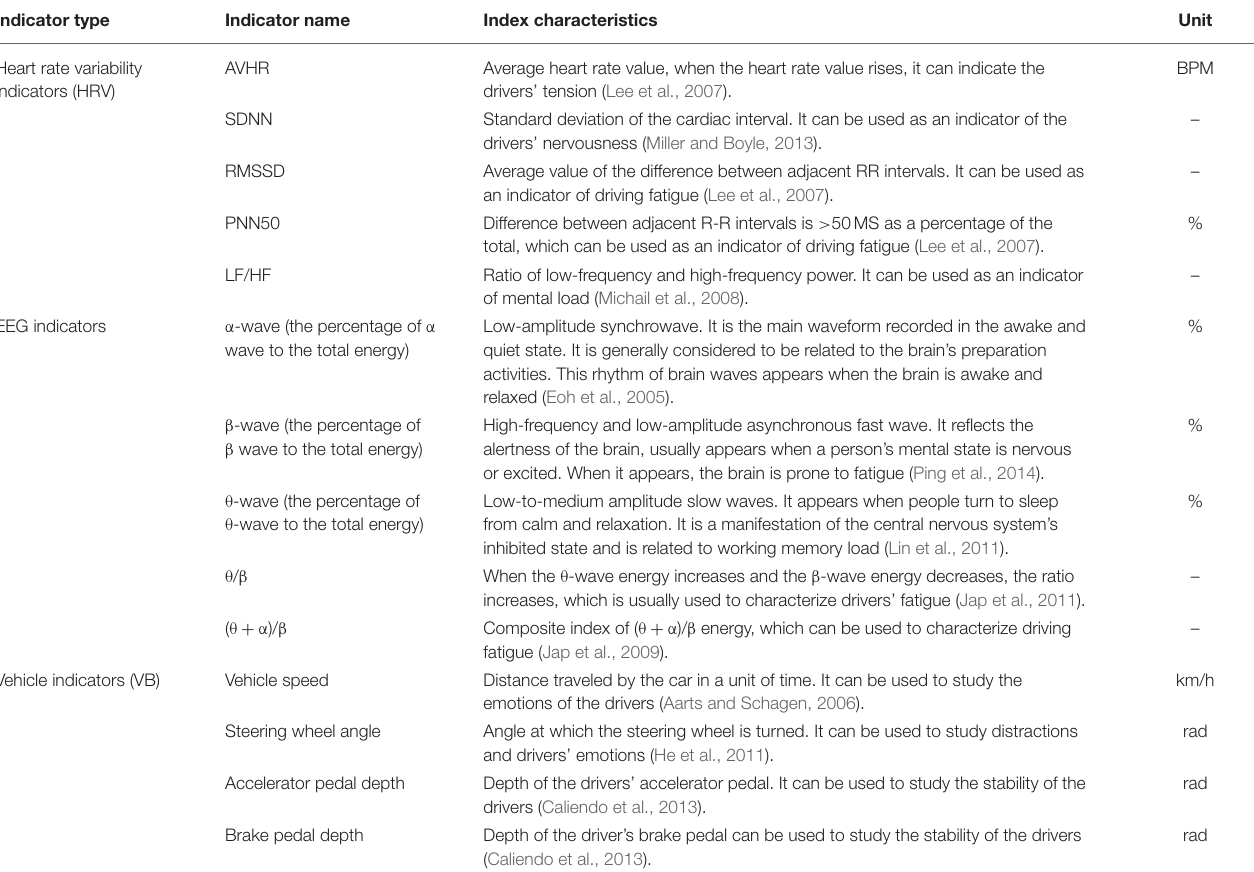
TABLE 2 | Driver’s physiological state and driving behavior indicators.